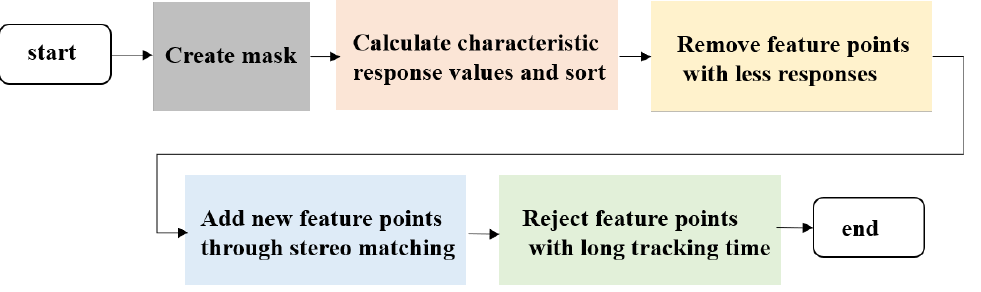
Figure 7. Feature point management algorithm flow chart.